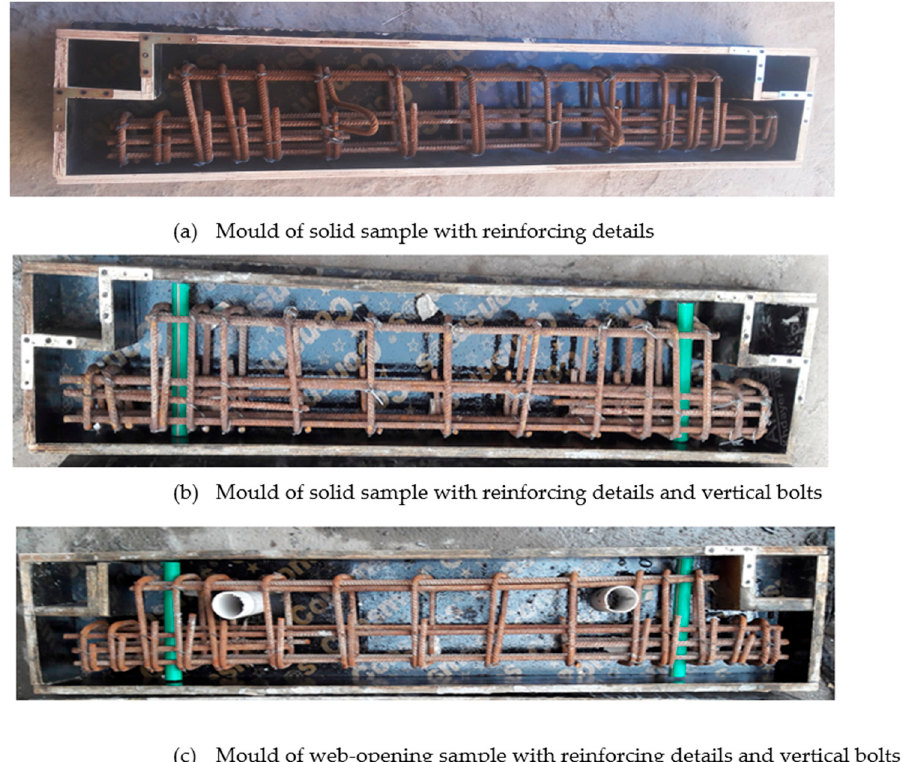
Figure 1. Section layout details of typical RC girders with dapped ends in the previous experimental investigation [39].